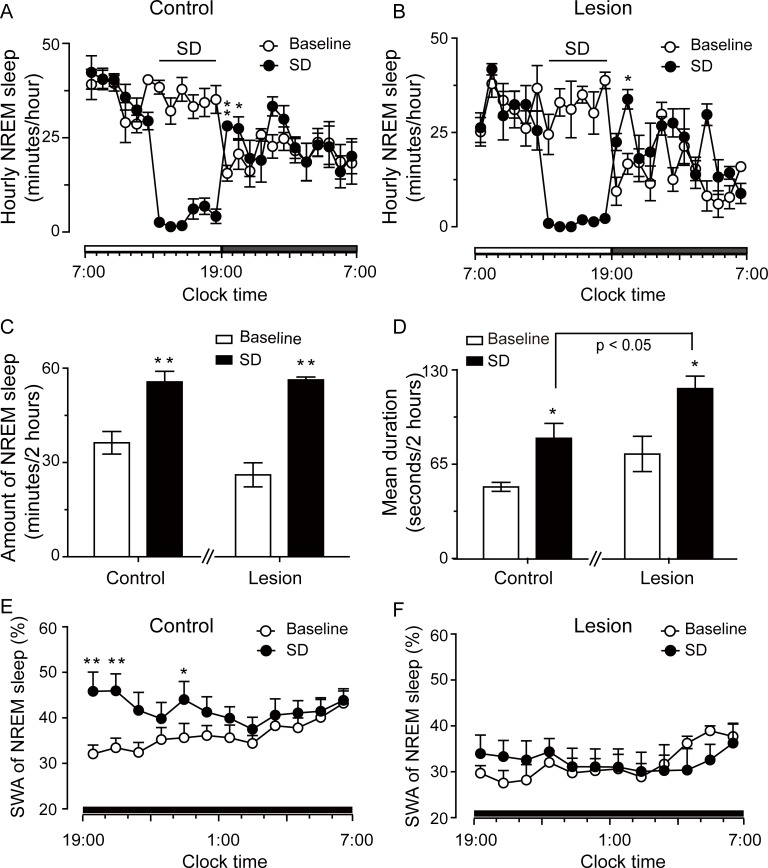
Rats with RMTg lesions by ibotenic acid for 8 days showed a deficit in rebound of non-rapid eye movement (NREM) sleep quality in response to 6-hour sleep deprivation (SD).(A, B) Time course of NREM sleep in control (A) and RMTg lesioned rats (B). Sleep was deprived from 13:00 to 19:00 hours. (C, D) Amount of NREM sleep (C) and mean duration of NREM sleep (D) during 19:00–21:00 hours following 6-hour SD. (E, F) Time course of slow-wave activity (SWA) (expressed as percentage of delta power [0.5–4 Hz] in NREM sleep per hour) from 19:00 to 07:00 hours following 6-hour SD in control (E) and RMTg lesioned rats (F). *p < 0.05, **p < 0.01 versus corresponding baseline using 2-way ANOVA followed by paired t tests. Control (n = 6); lesion (n = 4). The horizontal open and filled bars on the x-axes indicate the 12-hour light and the 12-hour dark period, respectively. Underlying data can be found in S1 Data.